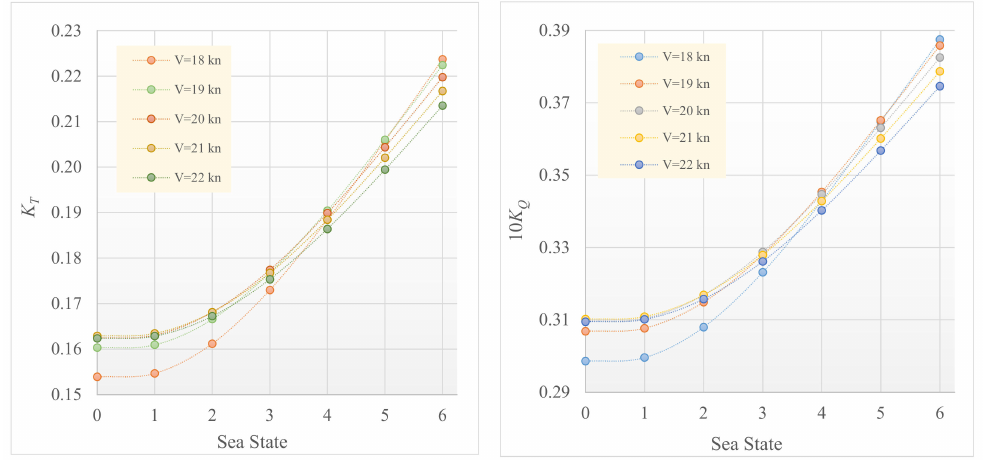
Figure 6. Propeller thrust ( left ) and torque coefficient ( right ) for different sailing speeds and sea